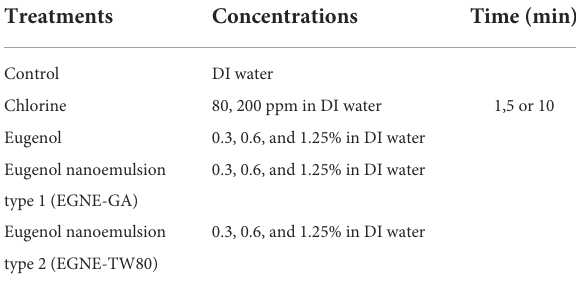
TABLE 1 Treatments used for washing cantaloupe rind plugs at 25 ◦ C. Treatments